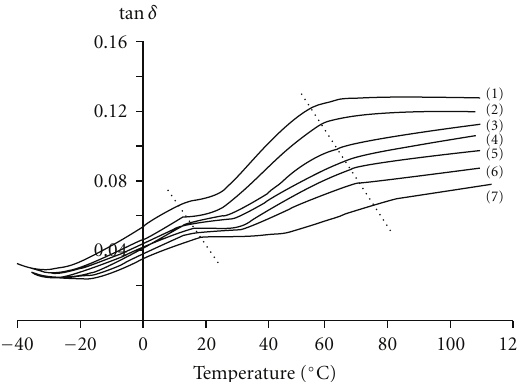
Figure 2: Loss modulus variation with temperature during DMTA experiment on unfilled PP.